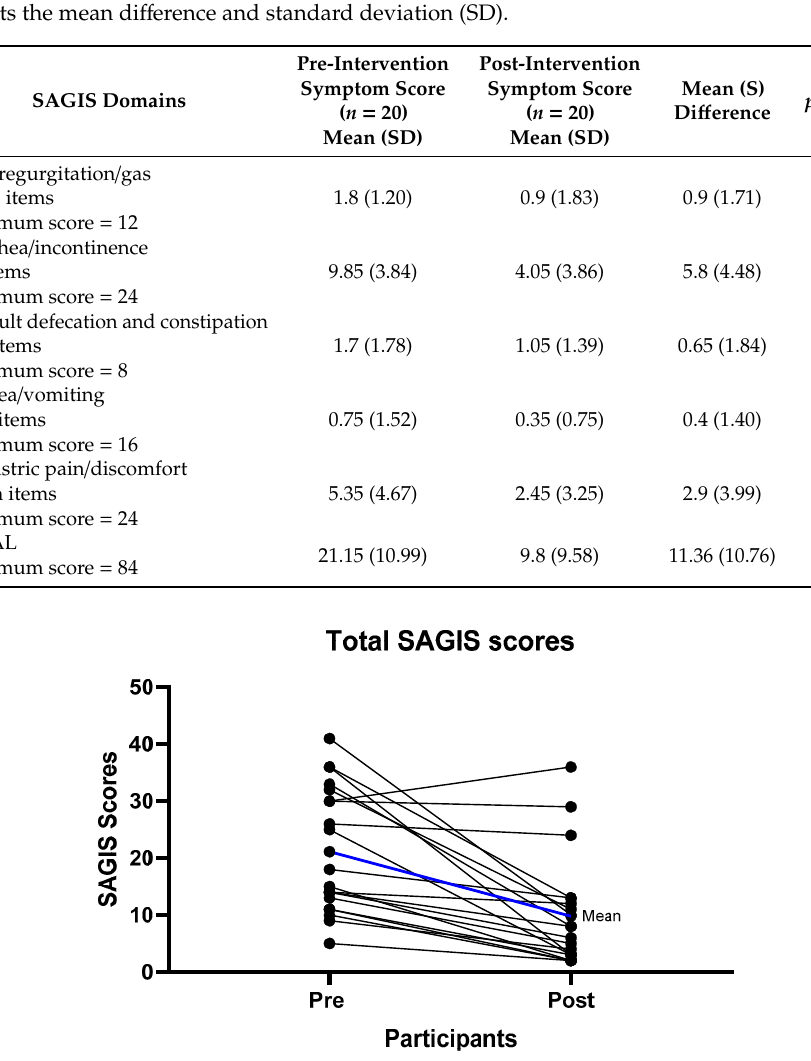
Figure 2. Individual gastrointestinal symptom improvement (Total Structured Assessment of Gastrointestinal Symptoms (SAGIS) scores) from baseline to follow-up. Mean difference from the pre intervention to follow-up scores was 11.35 with a standard deviation of 10.75 p < 0.001.